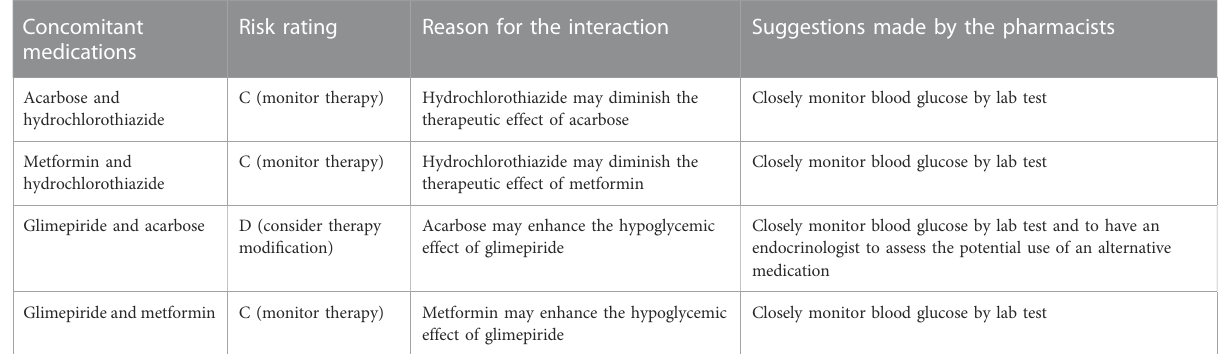
TABLE 5 DDIs identi fi ed by the